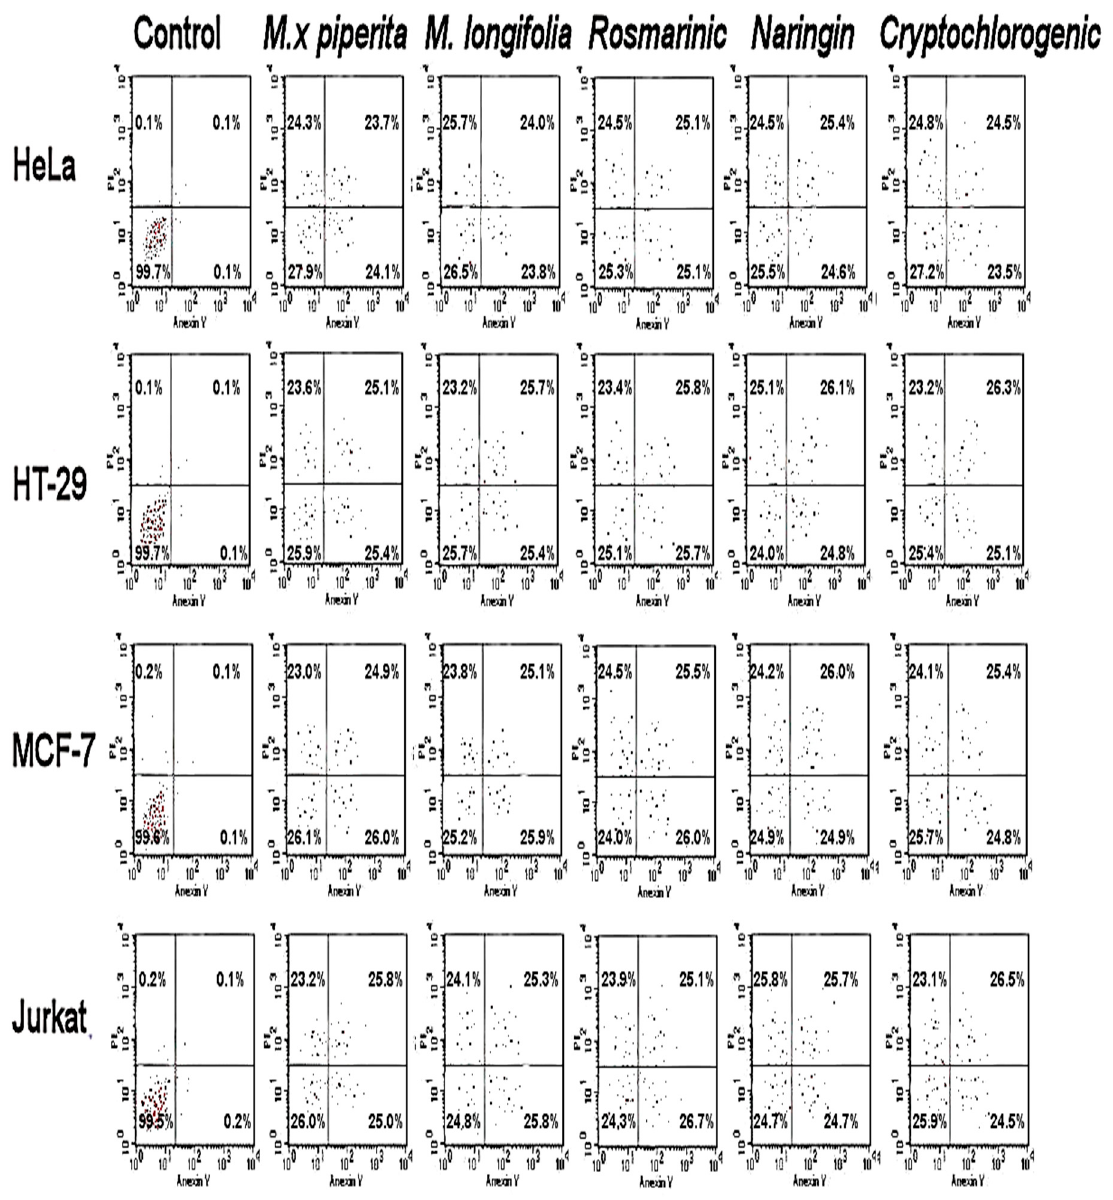
Figure 2. Cytotoxicity of the M. × piperita and M. longifolia leaf extracts and naringin, rosmarinic acid, and cryptochlorogenic acid, estimated with flow cytometry. There was accumulation of apoptotic cells in the early (lower right quadrant) and late apoptotic (upper right quadrant).